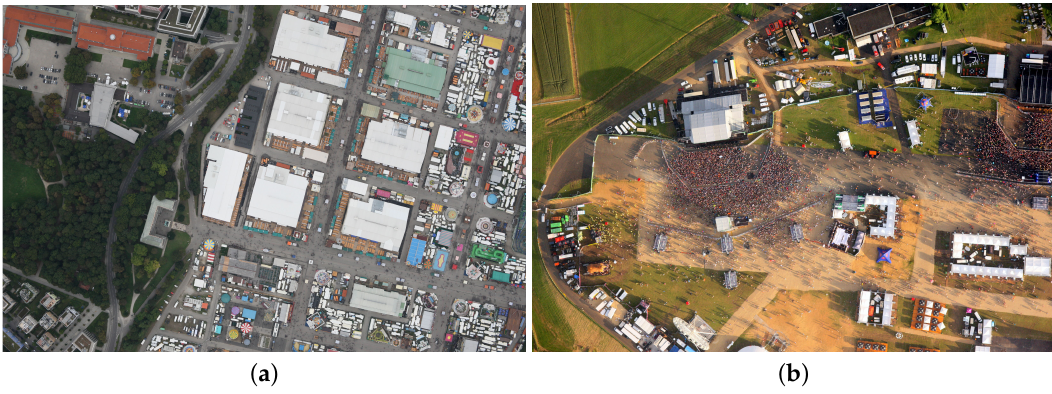
Figure 5. Example images of the DLR-ACD dataset. The images are from an open-air ( a ) festival ( b ) and music